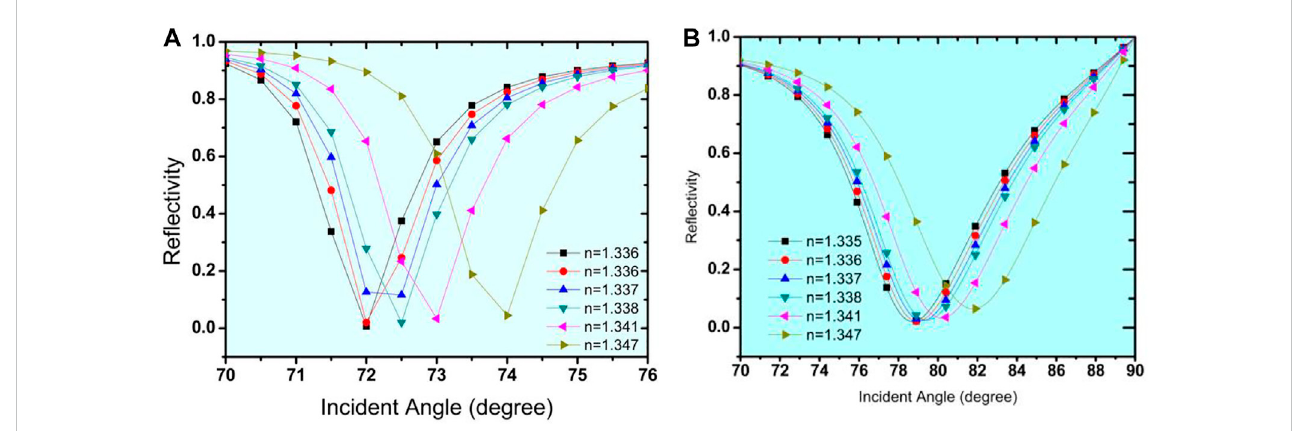
FIGURE 5 Re fl ectivitycurvewithrespecttochangesinincidentangleforthedetectionofurineglucoseinbio-sample (A) .ForStructure-I(Prism/Ag/Si/Bio-sample) (B) . For Structure-II (Prism/Au/Si/Bio-sample).